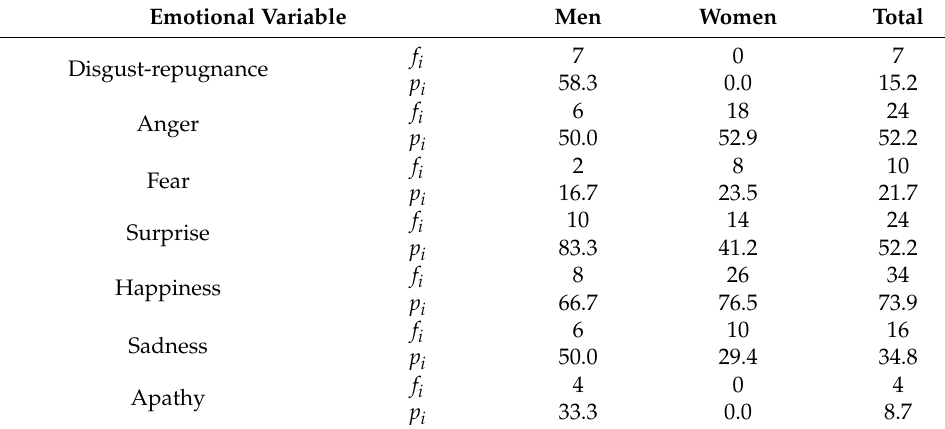
Table 4. Contingency table for the two variables: emotion and